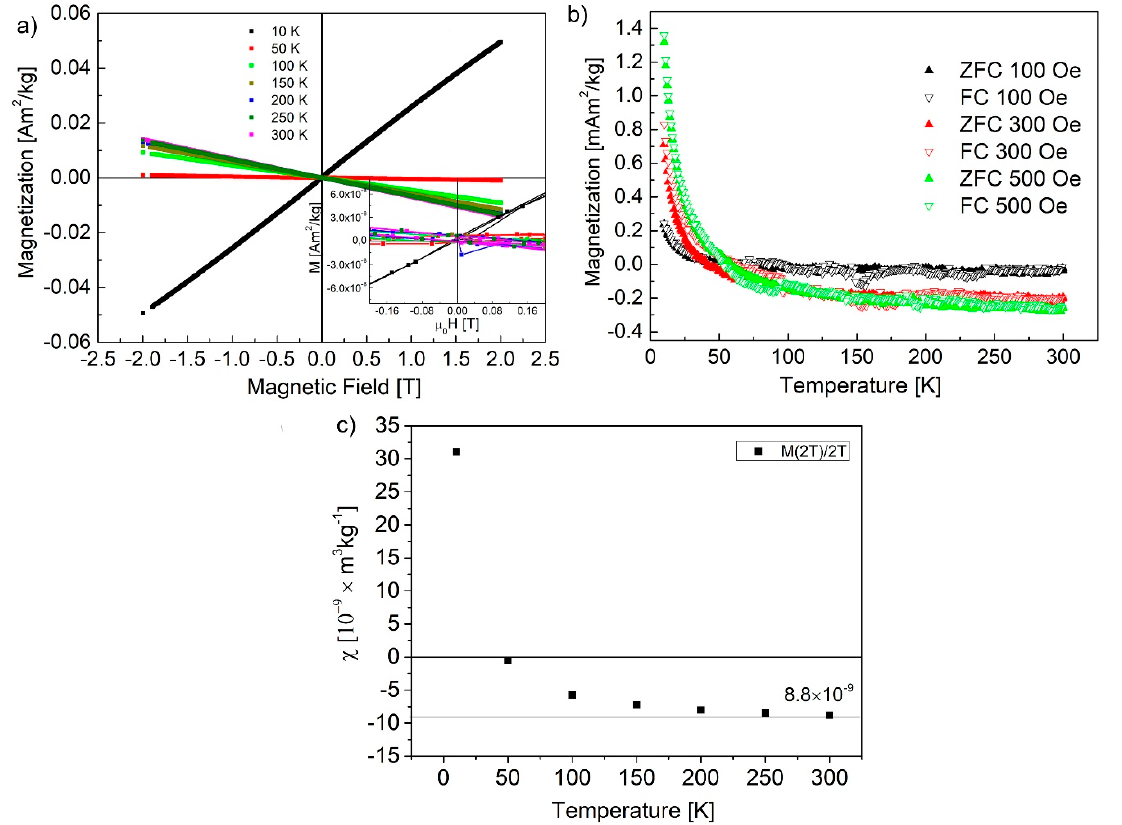
Figure 3. ( a ) Magnetization vs. magnetic field strength; ( b ) zero field cooling (ZFC) and field cooling (FC) dependences; ( c ) magnetic susceptibility recorded at 2 T for selected temperatures ( χ = M (2 T) / 2 T). All measurements were performed on obtained dried